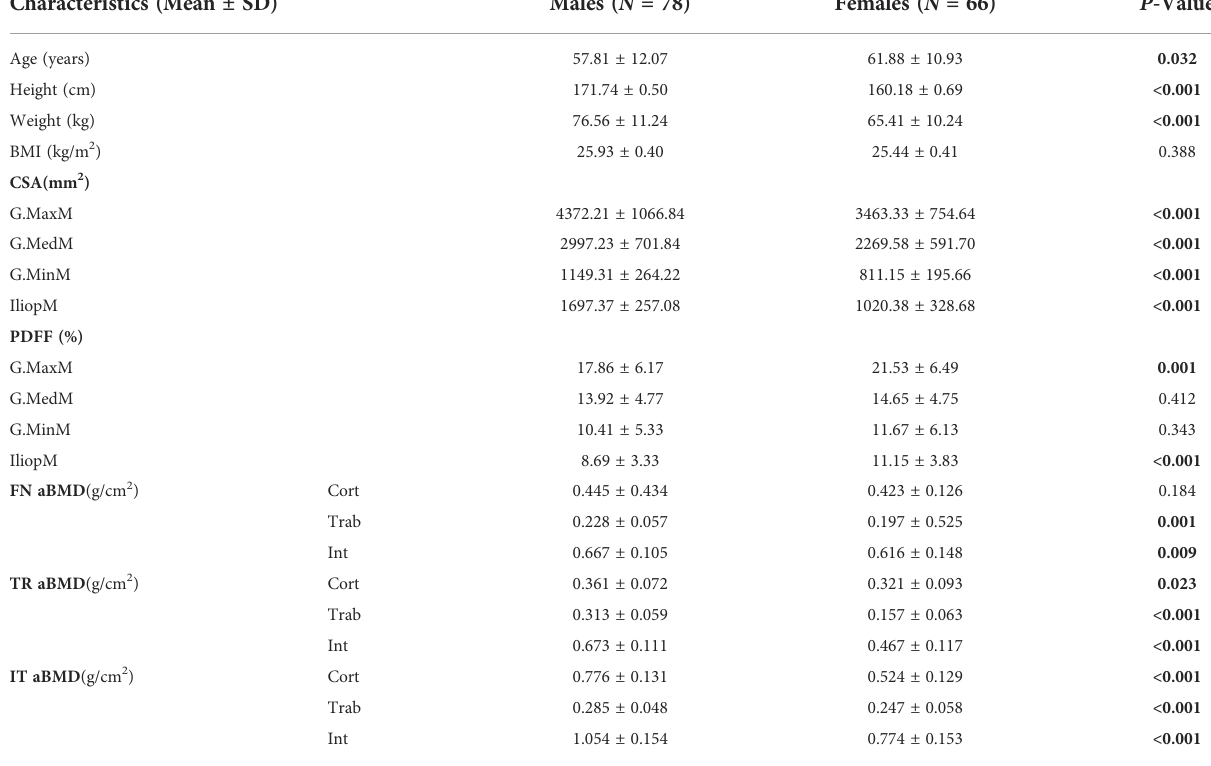
TABLE 1 Clinical characteristics of the subjects b